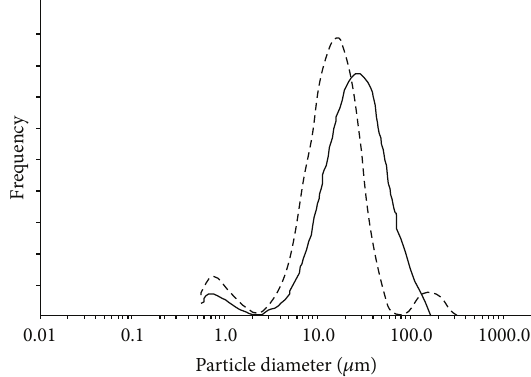
Figure 4: Particle size distribution of silicalite synthesized from RHA (SL6) in solid line and SG (SL7) in dashed